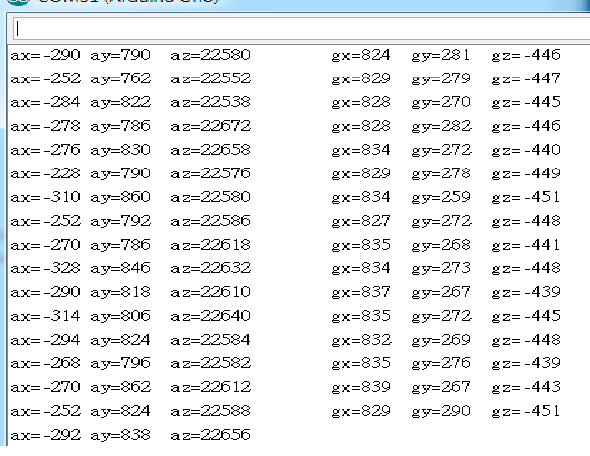
Figure 14. Six-axis sensor raw value.